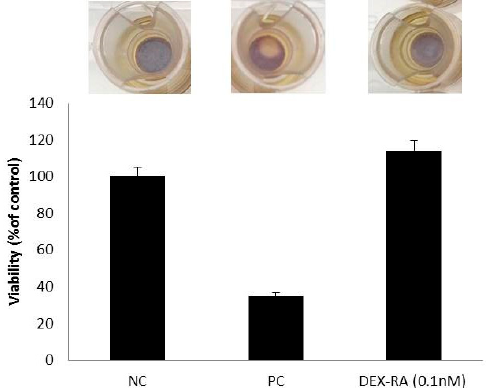
Figure 5. Effect of synthesized DEX-RA conjugates on EPISKIN™ RHE/L/13 human skin.